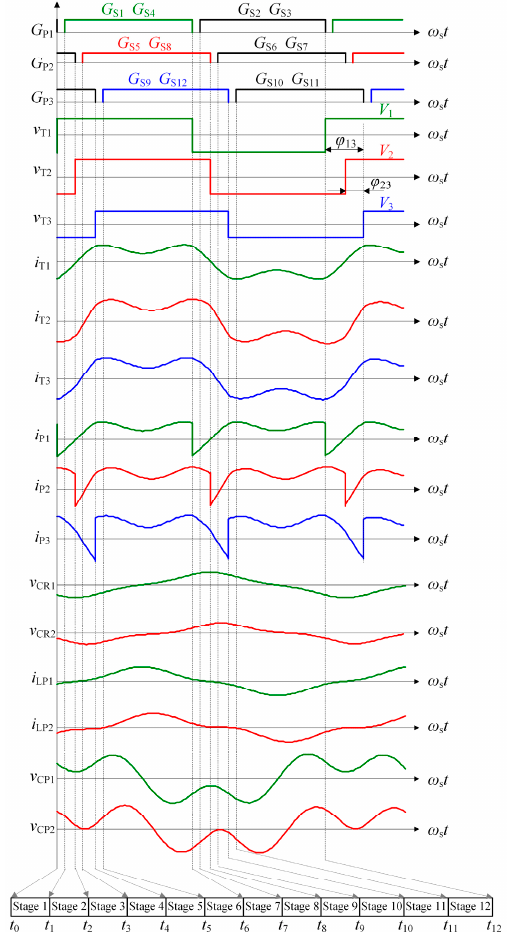
Figure 3. Theoretical waveforms of the proposed MR-TP-BDC.